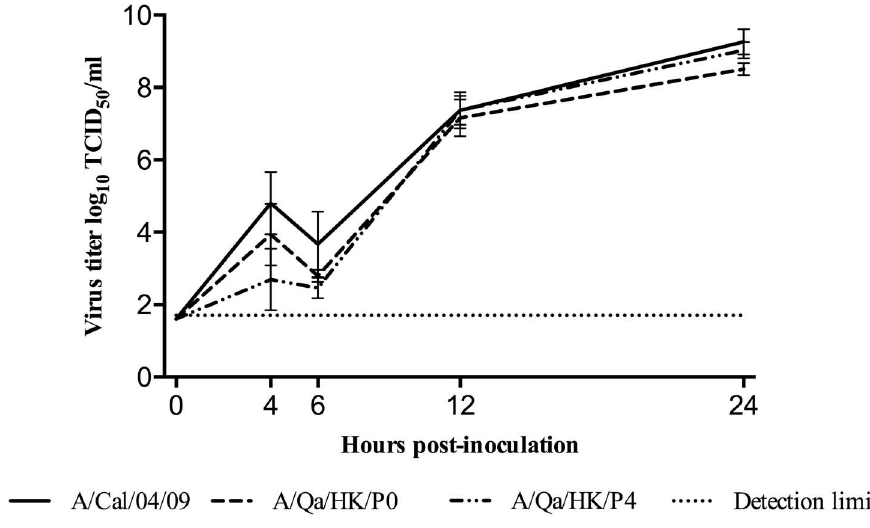
Fig 3. The effect of the serial passaging on the amount of virus produced over the course of the experiment using a single-step growth assay in MDCK cells. Each data point on the curve is the mean ± SD of the three